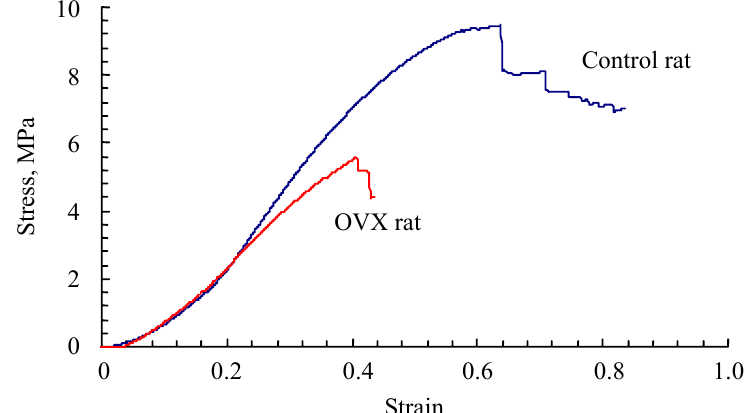
Typical stress-strain curves obtained with cylindrical resin specimens of both control and OVX rat in the craniocaudal orientations at 6